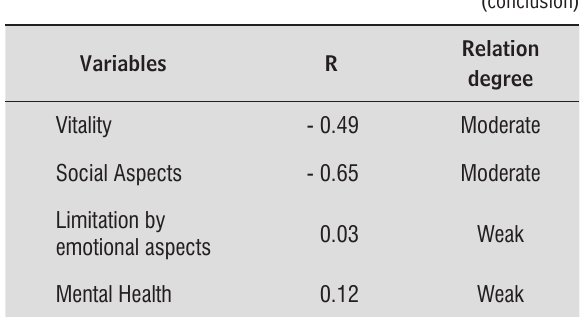
Table 3 - Correlation between quality of life and sleep- ing quality in patients with